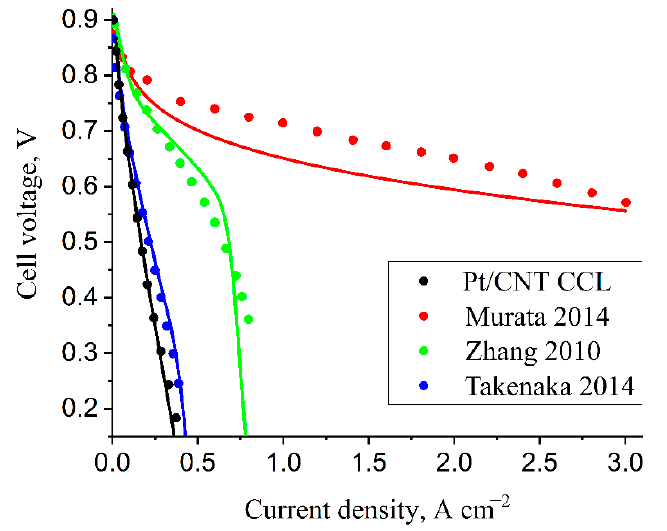
Figure 5. Experimental (dots) and model (lines) I–V curves of the PEMFCs with CCL based on Pt/CNT electrocatalysts [25,30,31].